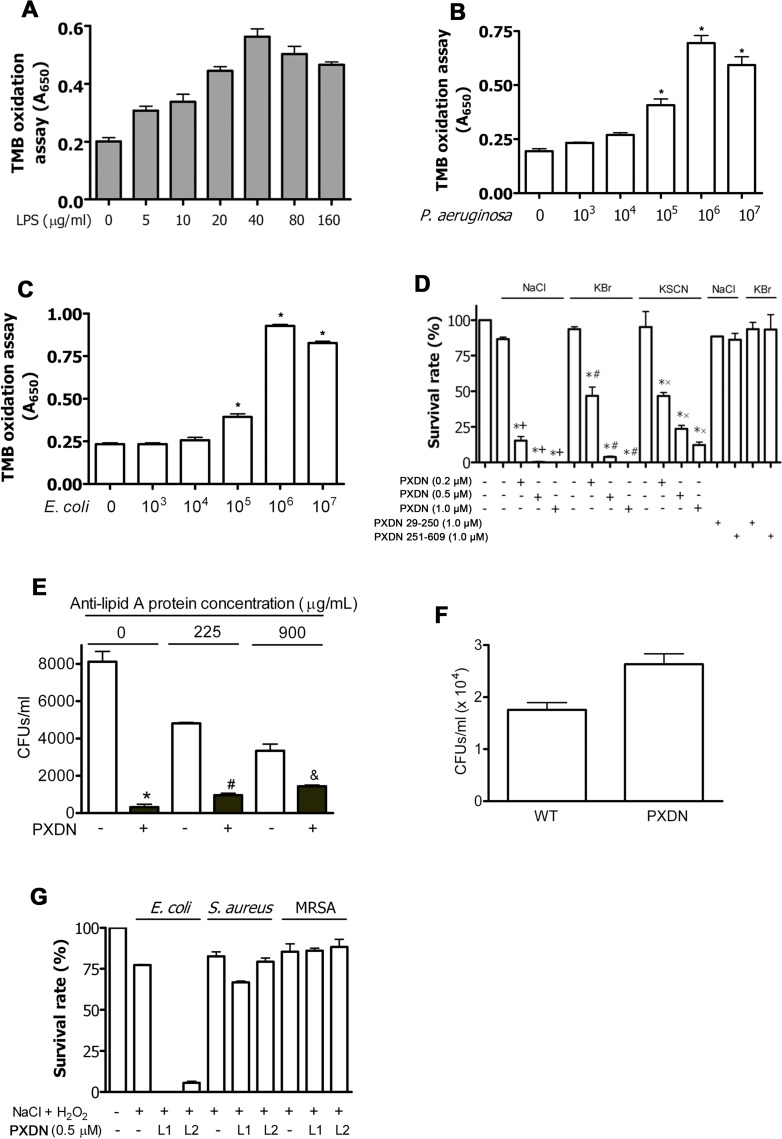
PXDN selectively kills GN bacteria in vitro.(A) LPS stimulates PXDN activity. Reaction mixtures (100 μL each) containing TMB solution, H2O2, recombinant FL-PXDN (400 nM/heme) and LPS as indicated were carried out at room temperature for 30 min. LPS and recombinant FL-PXDN were pre-incubated at 4°C for 30 min prior to mix with TMB solution. TMB oxidation was recorded at absorbance 650 nm. One-way analysis of variance, P < 0.001 for all comparisons. (B) Live P. aeruginosa stimulates PXDN activity. P. aeruginosa was pre-incubated with recombinant FL-PXDN at RT for 30 min in 20 mM of phosphate buffer without NaCl. The mixture was added into TMB solution (100 μL) and incubated at RT for 30 min. Absorbance at 650 nm was measured. *P<0.05 vs. non-bacteria control. (C)
E. coli stimulates PXDN activity. The same experiment was carried out as in “B” where P. aeruginosa was replaced by E. coli. *P<0.05 vs. non-bacteria control. (D) PXDN kills GN bacteria in vitro. P. aeruginosa strain K suspensions were incubated in 50 mM phosphate buffer (pH 6.2) containing indicated amounts of recombinant FL-PXDN or 1 μM of truncated PXDN (PXDN 29-250aa and PXDN 251-609aa), 10 μM H2O2, and halide (140 mM NaCl, 100 μM KBr or 100 μM KSCN) at 37°C for 1 h. Cell mixtures were plated on LB agar plates and incubated at 37°C overnight. The control group contained P. aeruginosa only (lane 1). The CFUs were counted, and relative survival rates were calculated as CFUs in the experimental group divided by those in the control group. *P < 0.001 vs. Control; +P < 0.001 vs. H2O2 + NaCl; #P < 0.001 vs. H2O2 + KBr; xP < 0.001 vs. H2O2 + KSCN. Data are representatives of three independent experiments. (E) Anti-lipid A antibody inhibits bacterial killing by PXDN. E. coli K12 was incubated in 50 mM phosphate buffer (pH 6.2) containing 2 μM recombinant PXDN, 10 μM H2O2, 140 mM NaCl and indicated amounts of anti-lipid A antibody, at 37°C for 1 h. Cell mixtures were plated on LB agar plates and incubated at 37°C overnight. The colonies were counted. Paired Student’s t-test: *P = 0.0031; #P = 0.0016; &P = 0.0464. (F) Sera from PXDN-deficient mice are impaired to kill bacteria. Sera from C57BL/6 and PXDN-deficient mice were used in the experiments. 100 μL reaction mixtures contained 50 μL serum and 50 μL PBS containing P. aeruginosa strain K and 50 μM H2O2. After incubation at 37°C for 1h, the mixture was plated on LB agar plates and incubated at 37°C for overnight. n = 3. P = 0.03. (G) PXDN cannot kill GP bacteria. The bacterial killing experiment was carried out similar to “D” in the presence of H2O2 and NaCl. Two lots of recombinant PXDN were utilized (L1 and L2). E. coli K12 was used as positive control. One-way analysis of variance, P < 0.001 for E. coli; P = 0.1308 for S. aureus; P = 0.6460 for MRSA. All data are representatives of at least three independent experiments.